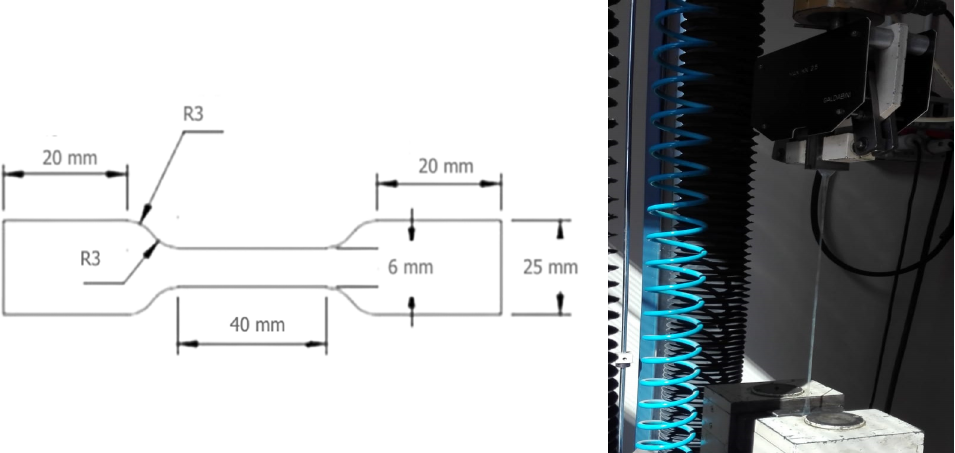
Figure 2. Mechanical analysis of greenhouse plastic films: specimen dimensions ( left ), tensile test ( right ).